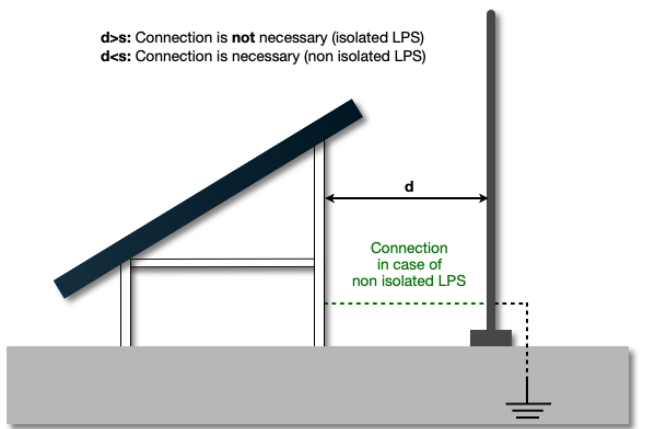
Figure 1. External lightning protection system of a photovoltaic (PV) installation (s: separation distance that depends on the class of the lightning protection system (LPS) as defined in IEC 62305, d: distance between the lightning rod and the support structure, the insulation characteristics, the length along the air termination and the down conductor and the lightning current flowing in the air termination and the down